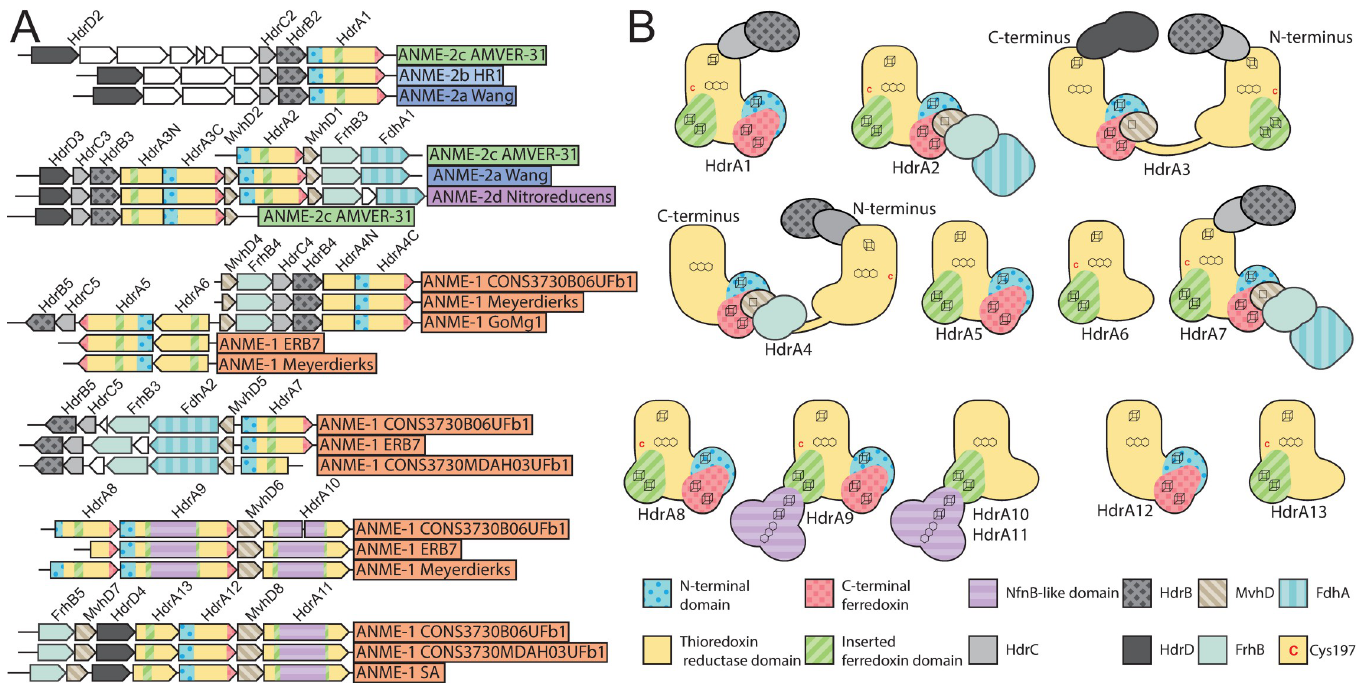
Fig 8. Hdr operons and domain heterogeneity. ( A ) Examples of gene clusters containing HdrA genes from select ANME genomes. HdrA paralogs present in ANME have extensive modification to the domain structure as compared to the HdrA crystalized from M . wolfeii (see Fig 7 for details of HdrA structure). These domains and associated protein subunits are illustrated with the gene context and orientation. ( B ) Illustration of conserved domains and cofactor binding residues in the 13 HdrA clusters defined here. All HdrA appeared to retain residues responsible for interaction with FAD; however, the presence of FeS-binding cysteine residues and entire domains as defined on the M . wolfeii structure are variably retained. Importantly, tandem or fused HdrA appear to have complementary presence/absence of C-terminal ferredoxin domains and Cys197, suggesting the formation of a heterodimeric complex. ANME, anaerobic methanotrophic; FAD, flavin adenine dinucleotide.